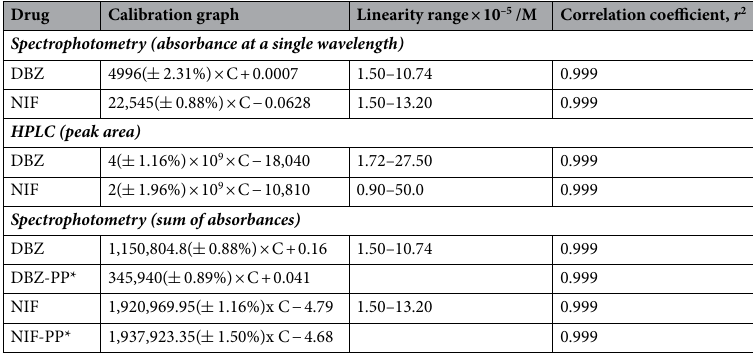
Table 1. Calibration features of the drugs. *PP is the photoproduct of the